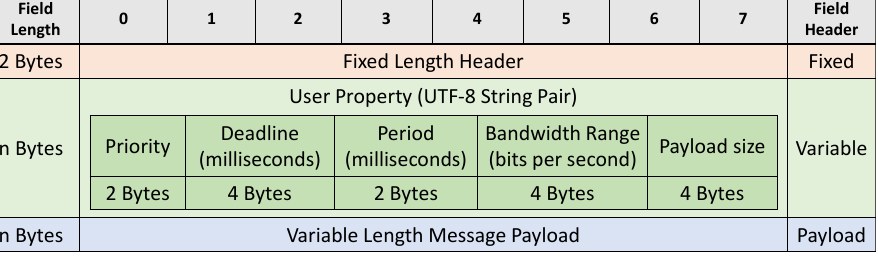
Figure 2. Structure of real-time attributes specification in RT-MQTT.